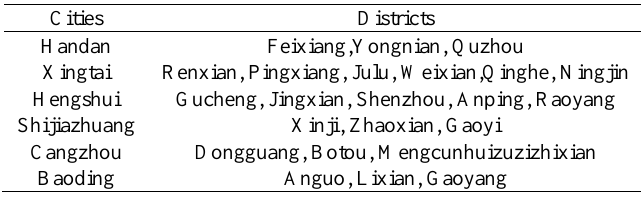
Table 4. Deformation